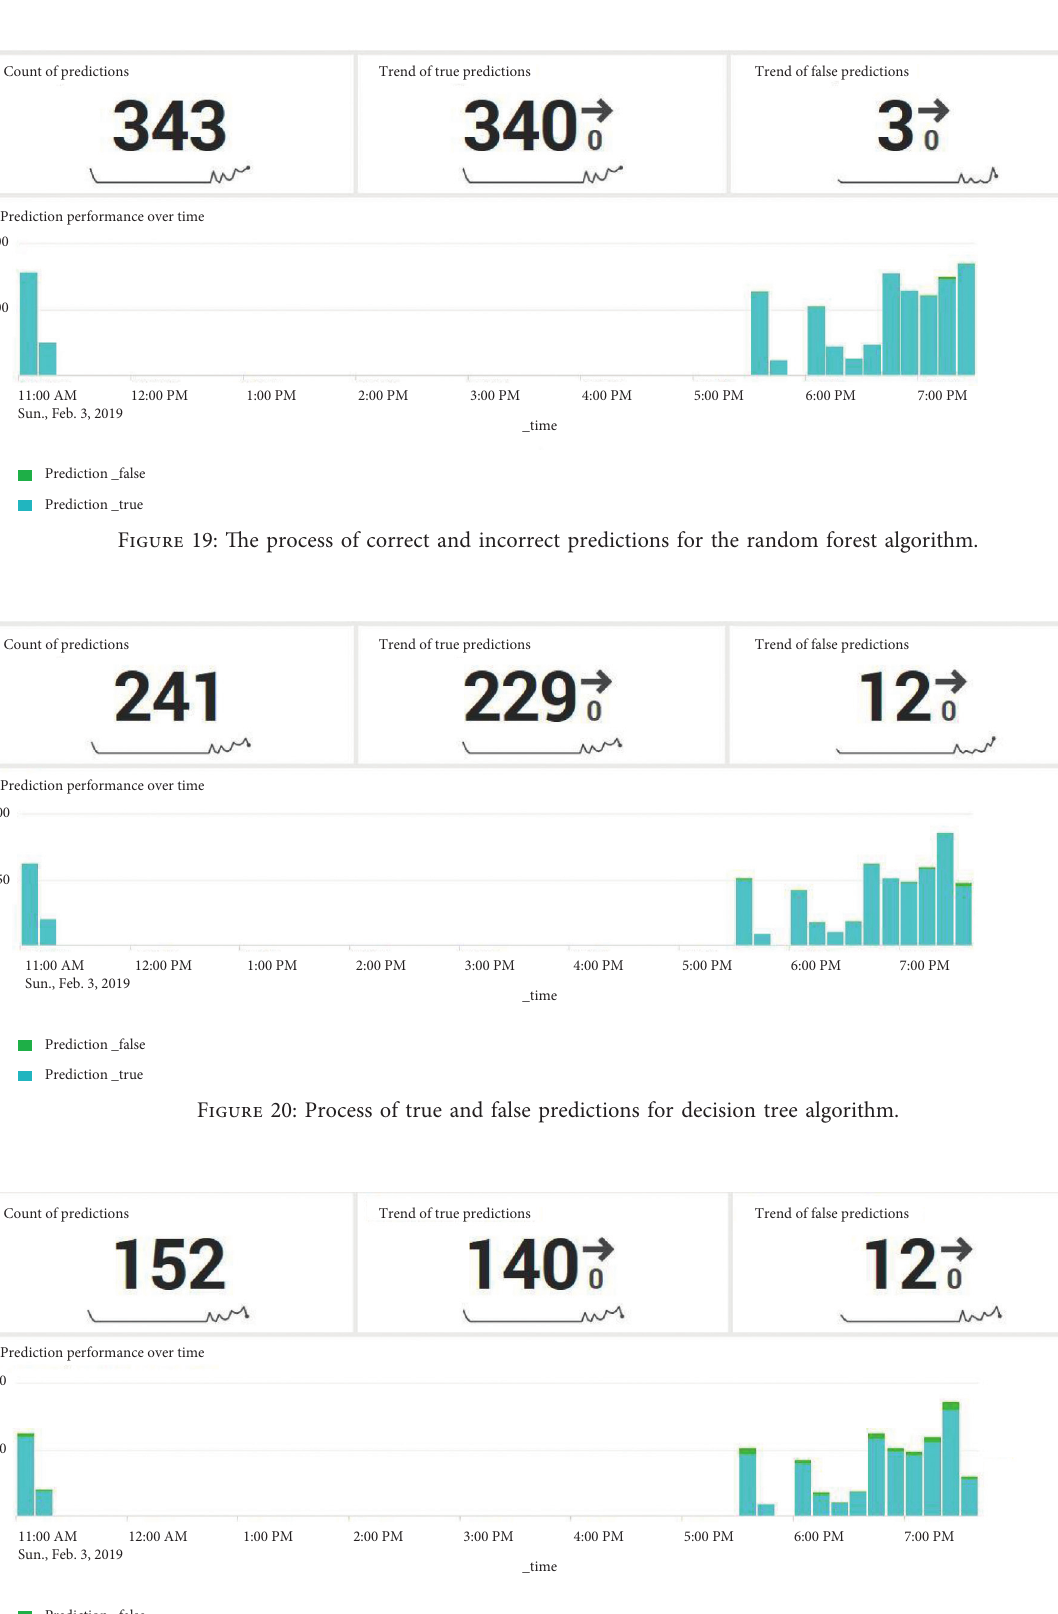
Figure 21: True and false prediction process for logistic regression